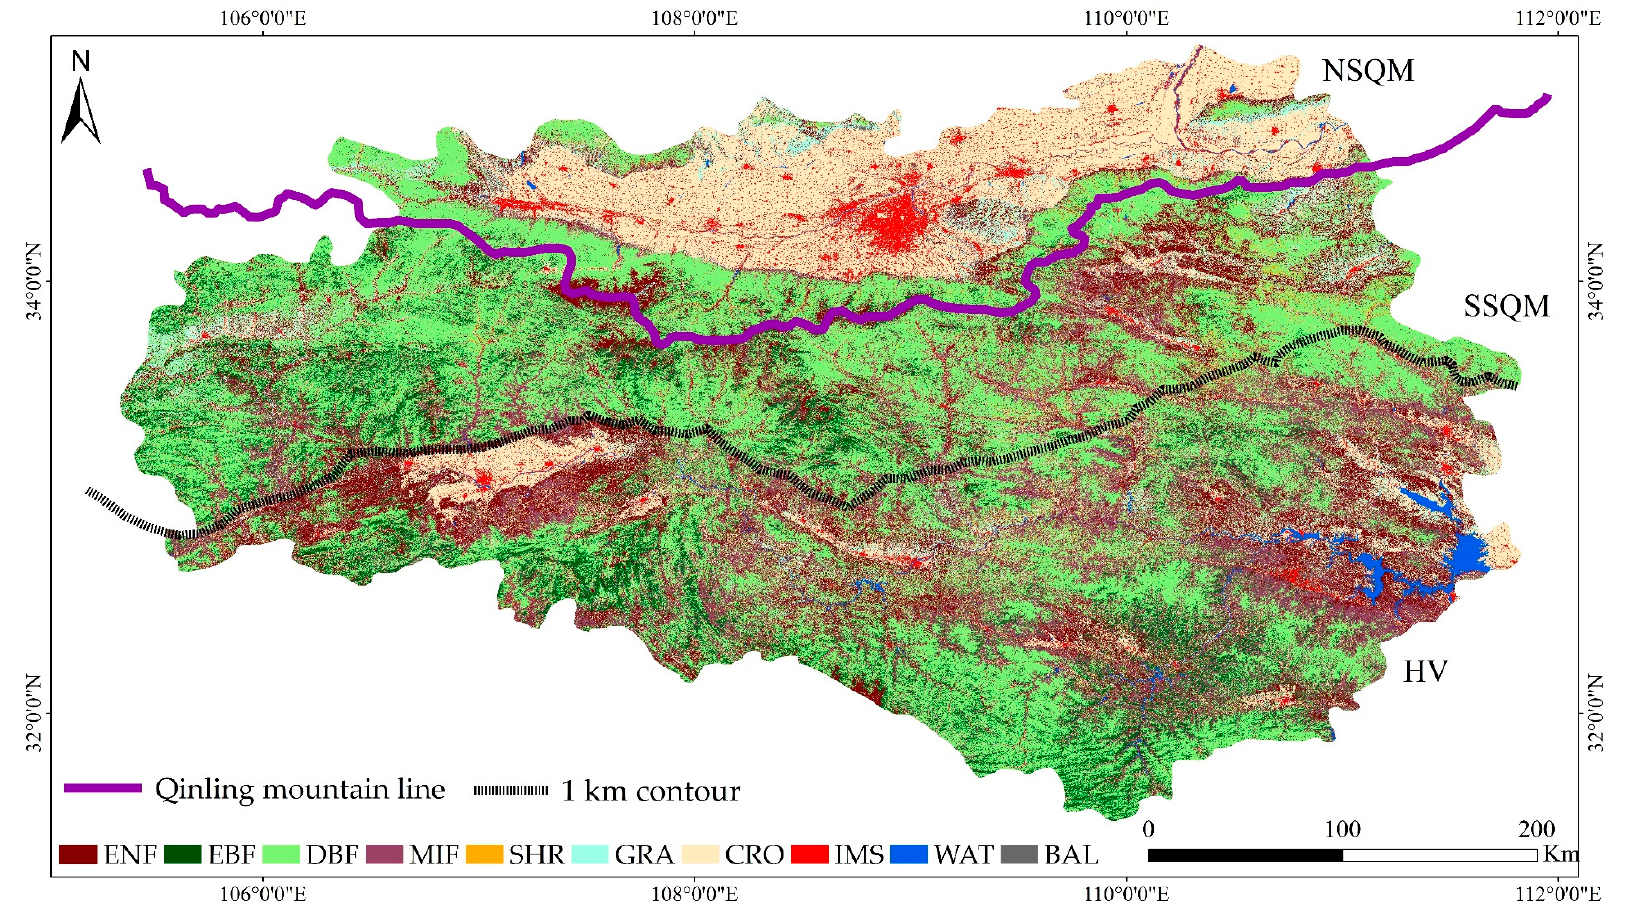
Figure 6. Classification map based on SST random forest classifier. Each color corresponds to an individual forest or land cover type, including Evergreen needleleaf forest (ENF), Evergreen broadleaf forest (EBF), Mixed forest (MIF), Shrub (SHR), Grassland (GRA), Cropland (CRO), Impervious surface (IMS), Water (WAT), and Bare land (BAL).